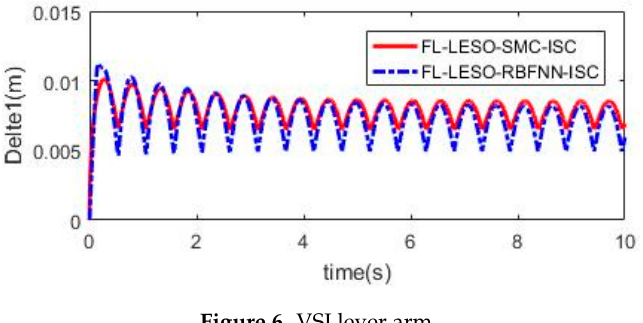
Figure 6. VSJ lever arm.